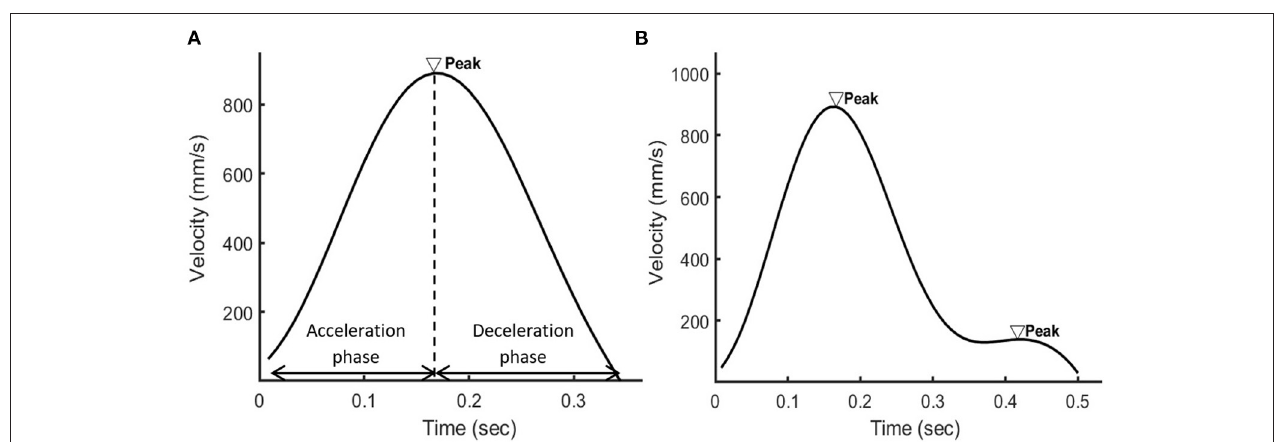
FIGURE 3 | The velocity profile of the wrist marker when (A) a healthy person or (B) a patient with schizophrenia used the right hand to reach for the object. In the velocity profile of the healthy person, there were one acceleration phase and one deceleration phase in the velocity profile and thus one peak. In the velocity profile of the patient, there were two